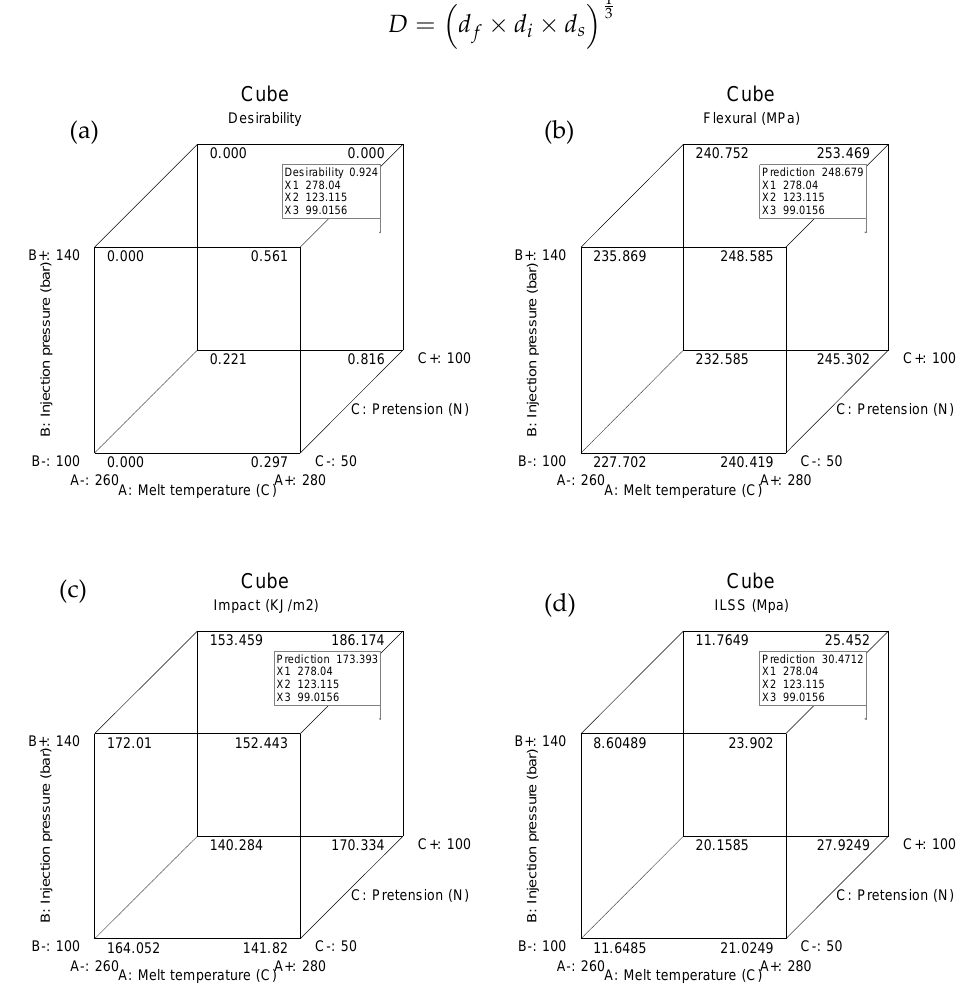
Figure 5. Optimization results: ( a ) desirability; ( b ) flexural strength; ( c ) impact strength; ( d ) ILSS.